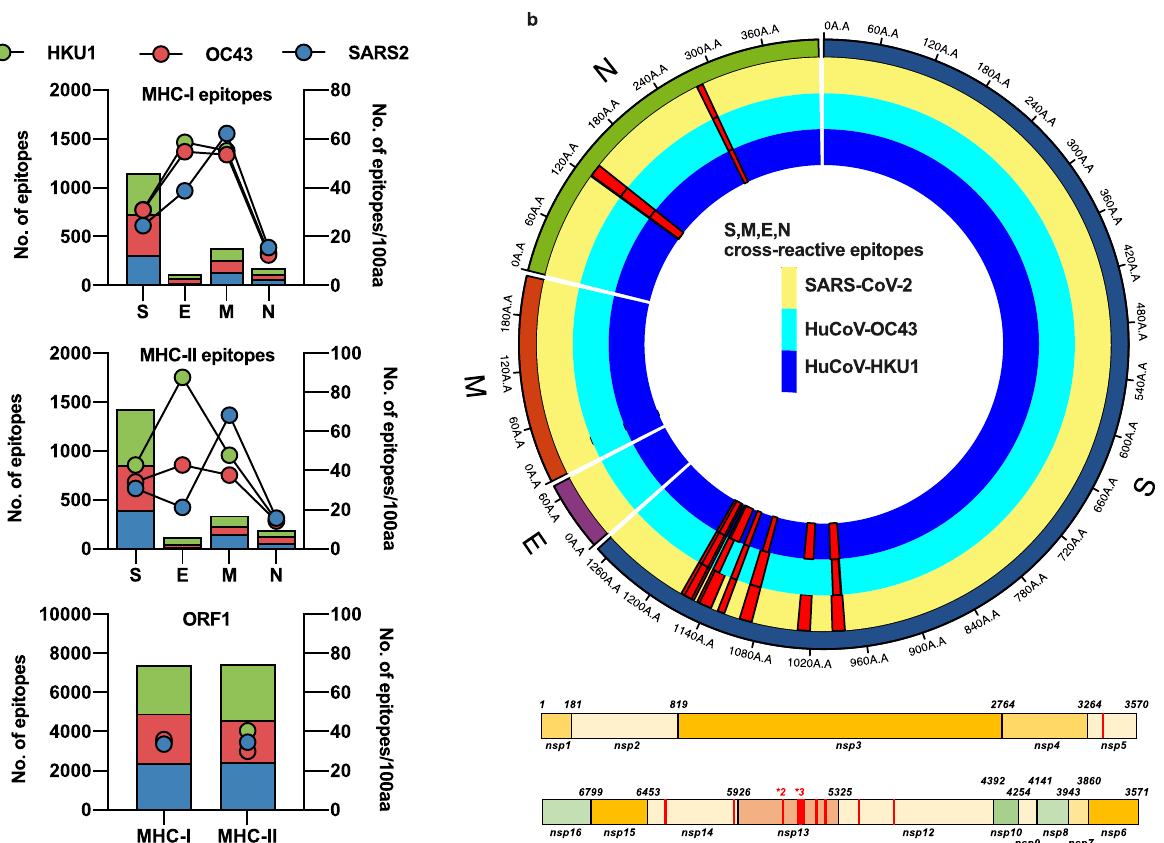
Fig. 1 In silico prediction of putative epitopes in human endemic beta-coronaviruses and SARS-CoV-2. Available sequences for S, M, E, N and ORF1 from SARS-CoV-2, huCoV-OC43 and huCoV-HKU1 were assessed for potential HLA-binding motifs by SYFPEITHI and IEDB as described in the Methods. The number of predicted epitopes is presented in the stacked bar charts and the immunogenicity for each protein of each virus is depicted as points on the right Y -axis. Green bars and circles depict huCoV-HKU1 (HKU1), red huCoV-OC43 (OC43) and blue SARS-CoV-2 (SARS2) ( a ). The predicted cross-reactive epitopes and their prevalence within each virus for all sequences available are mapped as red histograms in a linear plot for ORF1 and a radial plot for S, M, E and N. All mapped cross-reactive epitopes within ORF1 were present across SARS-CoV-2, HKU1 and OC43. Within the radial plot, the yellow track represents SARS-CoV-2 sequence, dark blue HKU1 and light blue OC43, with red histograms representing the prevalence of the putative epitope across the viruses ( b